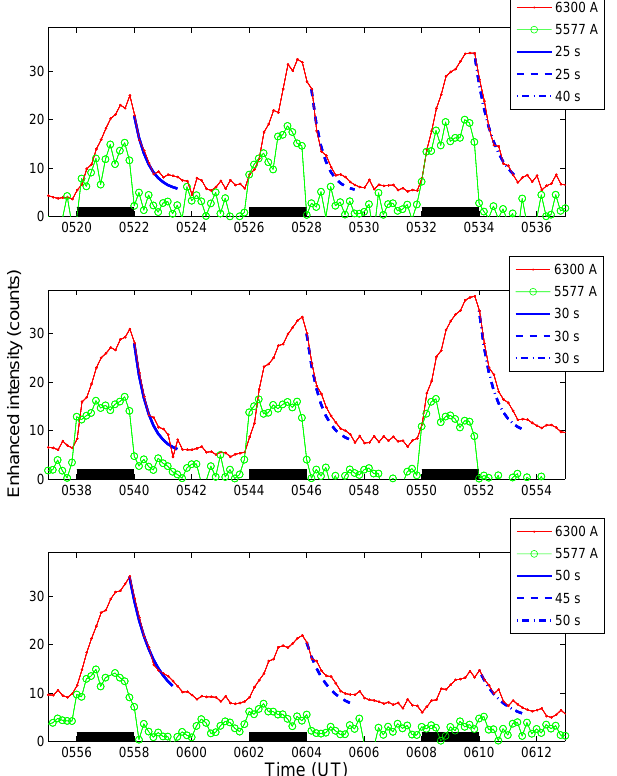
Fig. 11. The three panels display the average enhanced intensity at 5577 ˚A (green curve with o markers) and at 6300 ˚A (red curve with dot markers) together with the best fit decay curves for each pulse (blue curves). The black bar marks the 2min period of CW